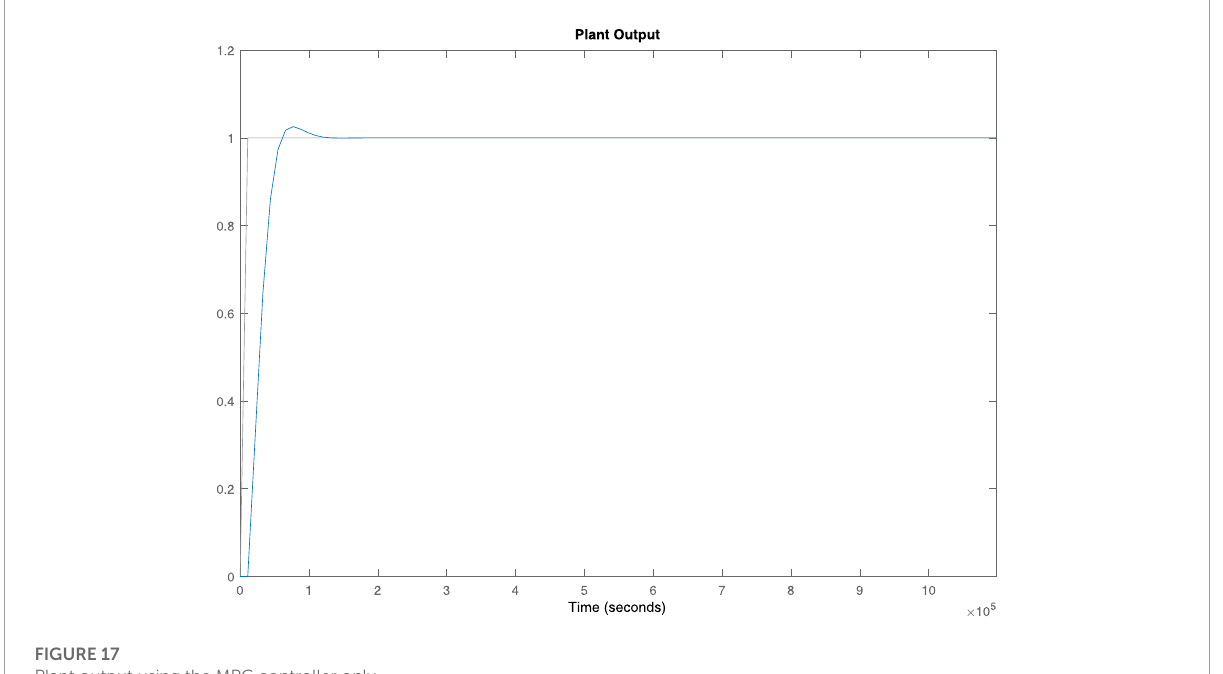
FIGURE 17 Plant output using the MPC controller only.